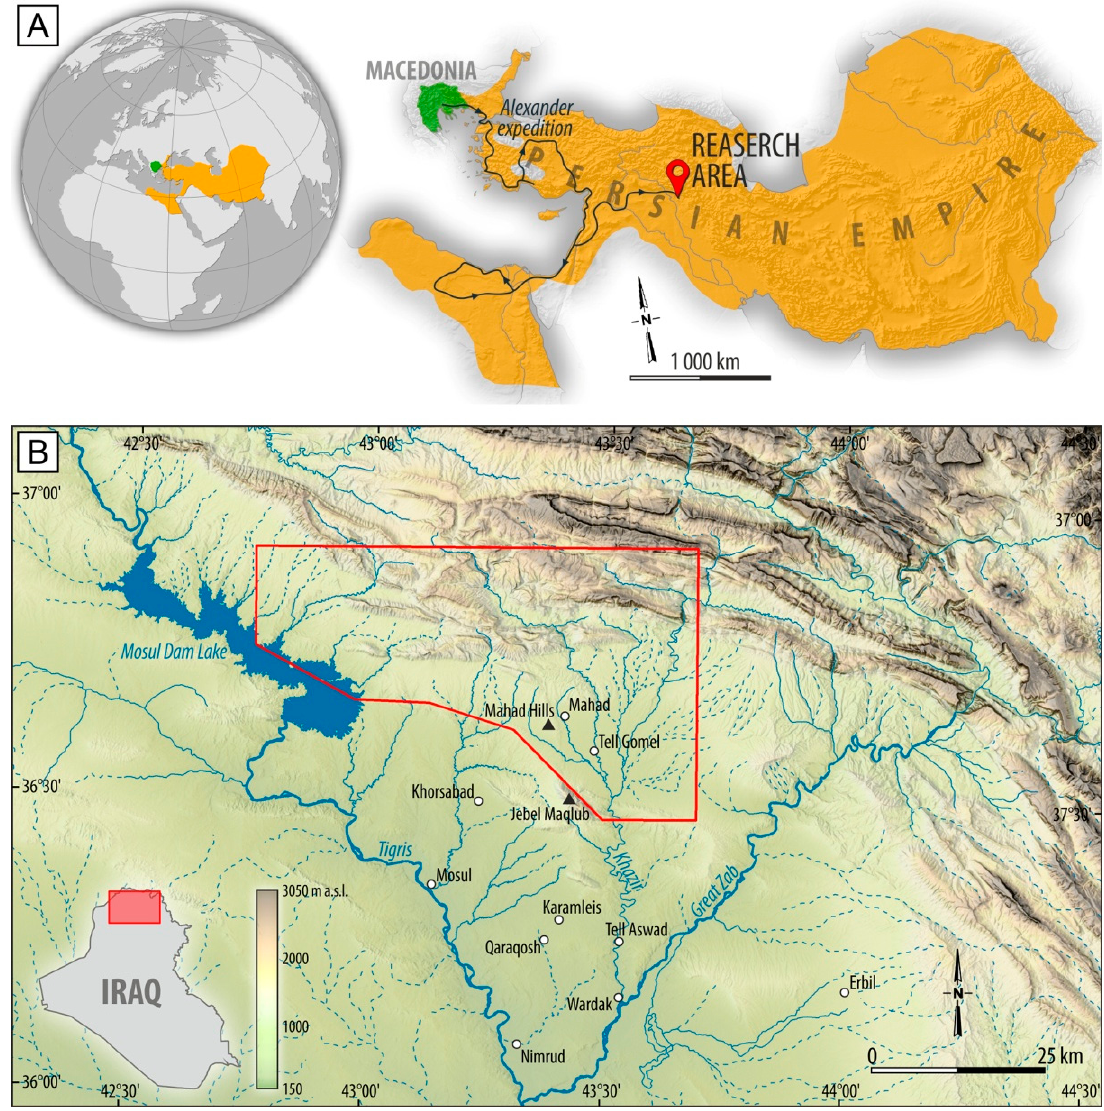
Figure 1. Area of interest. ( A ) General historical context: Macedon and Persia (in the time of Alexander the Great and Darius III). After Historical Atlas of the World , Warszawa 1986. ( B ) Geographical and topographical context (including the license area of the Land of Nineveh Archaeological Project (LoNAP), marked by the red polygon). Own map created on the basis of www.earthexplorer.usgs.gov (for altitude data), OpenStreetMaps, and Tactical Pilotage Chart, 1997, sheet G ‐ 4 and G ‐ 4C (for surface waters).